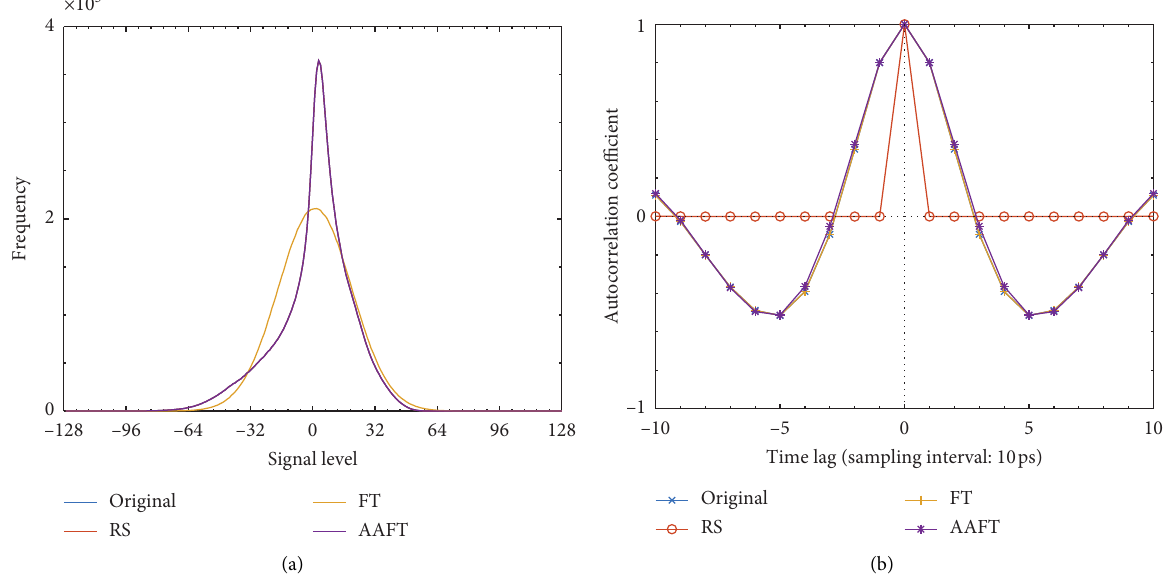
Figure 5: Characteristics of laser chaos time series and its RS, FT, and AAFTsurrogates: (a) signal level histogram and (b) autocorrelation